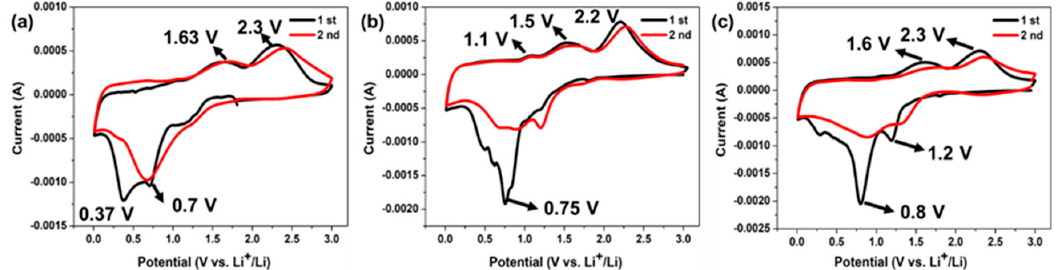
Figure 6. Cyclic voltammetry measure of ( a ) NiCo 2 O 4 , ( b ) CuCo 2 O 4 , and ( c ) Cu 0.6 Ni 0.4 Co 2 O 4 .